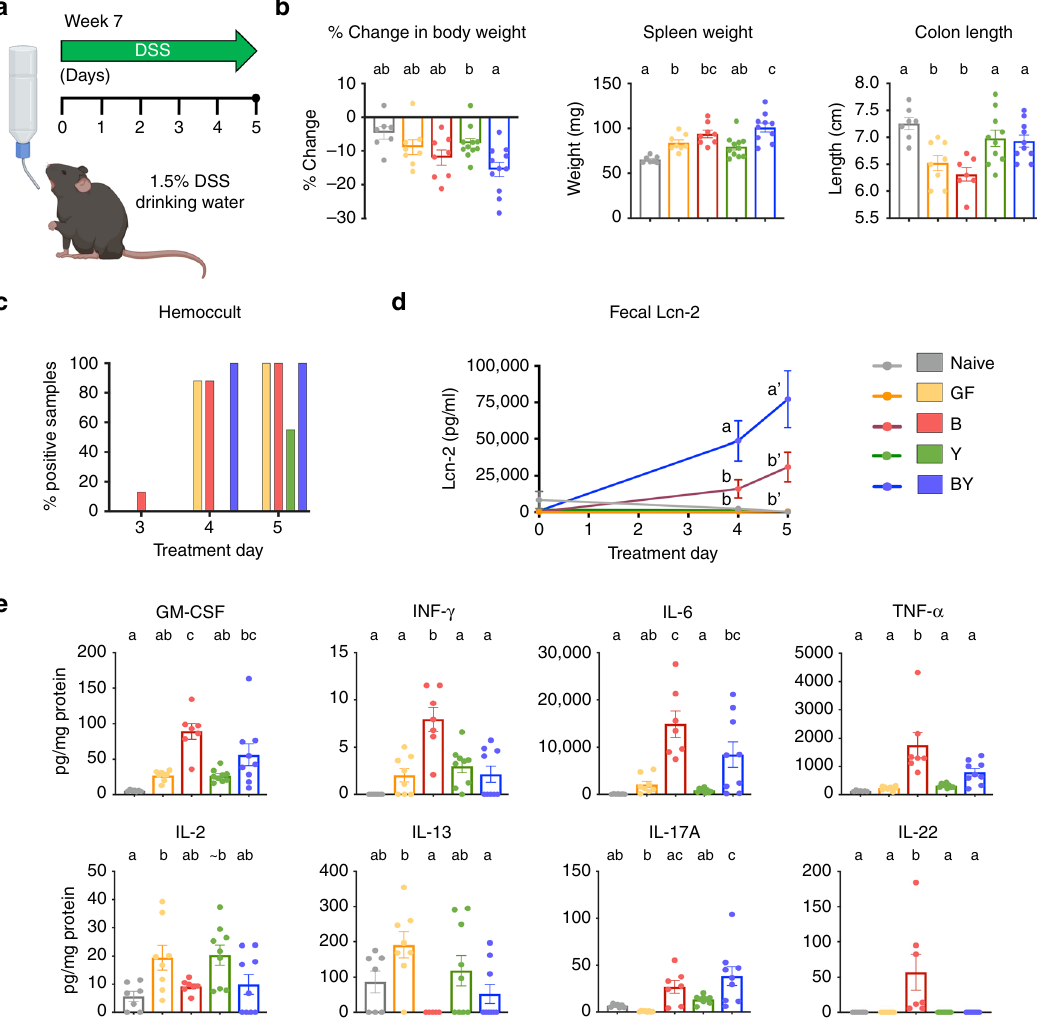
Fig. 2 Fungal immune modulation of DSS-induced colitis. a Experimental layout for DSS study. Seven-week-old gnotobiotic F1 mice were treated with 1.5% DSS for 5 days and colonic in fl ammation was assessed at end of treatment. A group of colonized animals were not treated with DSS and denoted naive (see Methods). b Percentage weight change between days 1 and 5, spleen weight, and colon length after 5 days of DSS treatment. Measurements of c stool occult blood and d stool Lcn-2 throughout DSS treatment. e Pro-in fl ammatory cytokines detected in in fl amed colon lysates by electrochemilumine- scence (MSD). b – e Data expressed as mean ± S.E.M.; color denotes colonization and DSS treatment (Naive = gray, GF = yellow, B = red, Y = green, BY